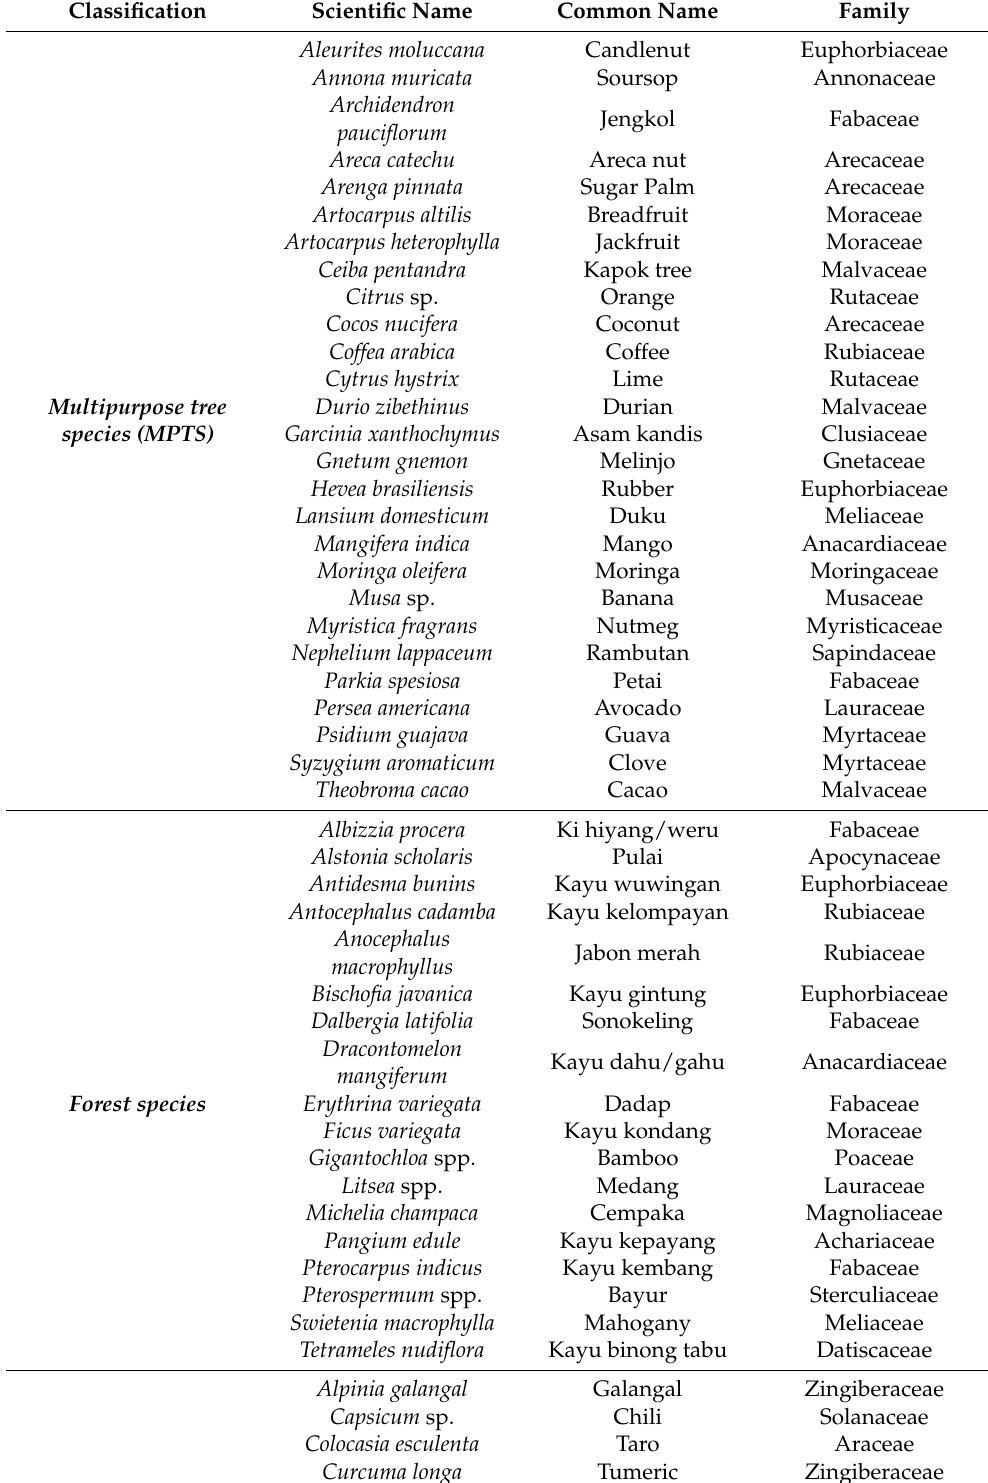
Table A1. Cultivated species in the plots of interviewed farmers in Bogorejo and Cilimus Villages in WAR